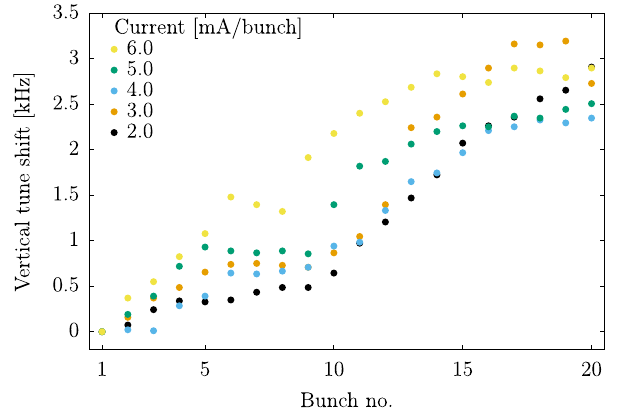
FIG. 1. Vertical betatron tune shifts measured using the “ pinging ” method along a 20-bunch train of positrons at 5.3 GeV for values of the bunch current ranging from 2 to 6 mA = bunch ( 3 . 2 – 9 . 6 × 10 10 bunch